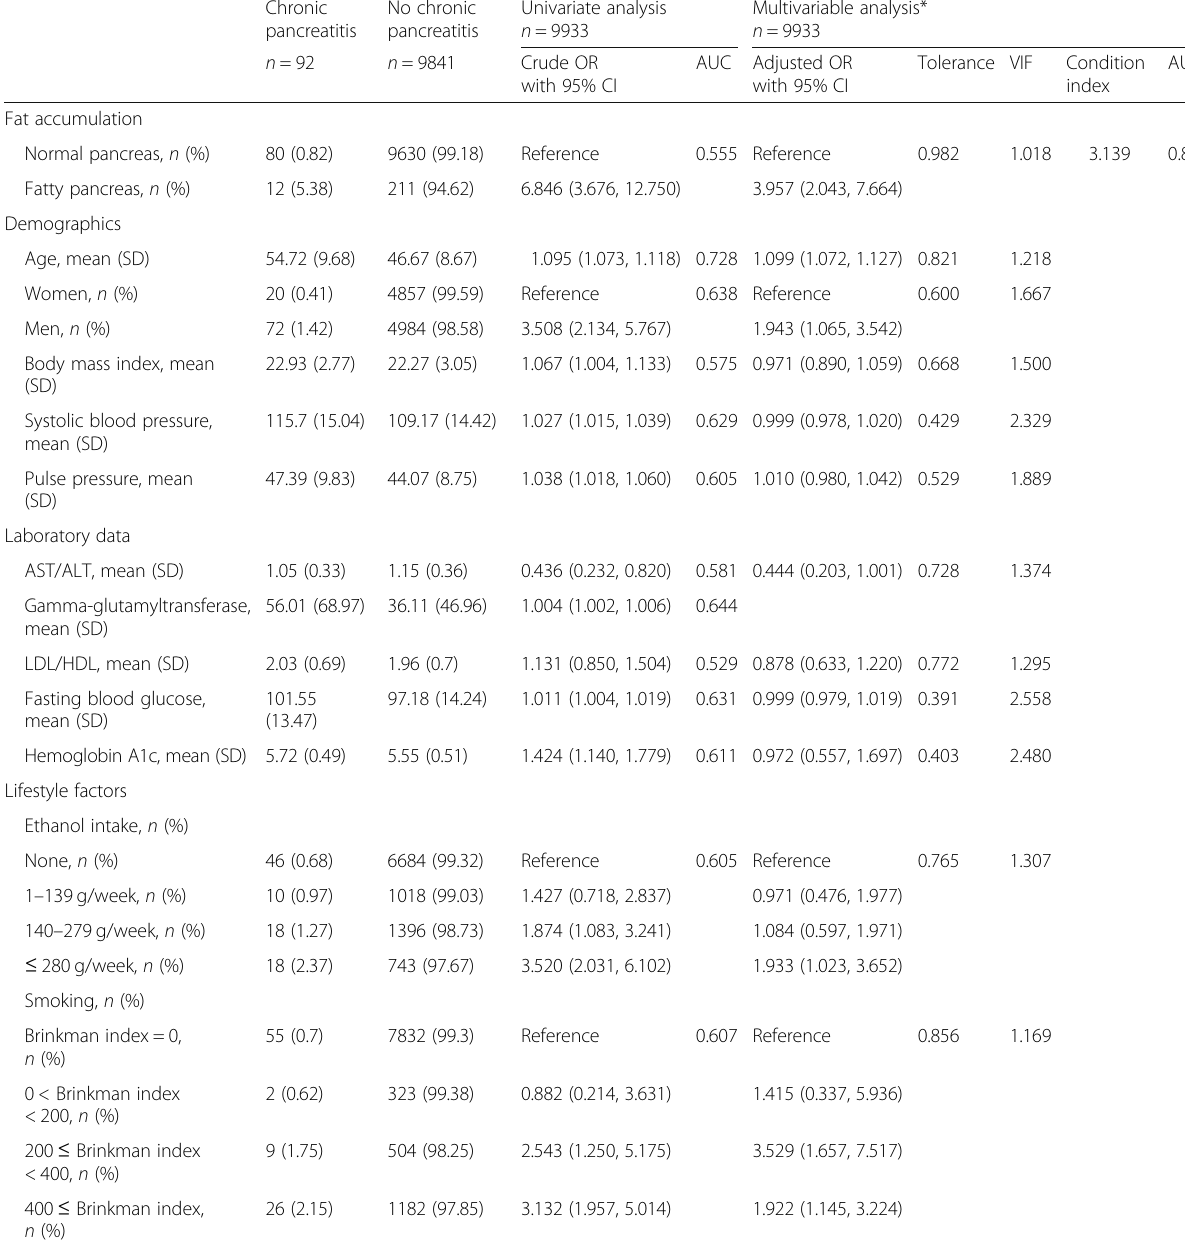
Table 2 Multivariable-adjusted odds ratio for the development of chronic pancreatitis in participants with fatty